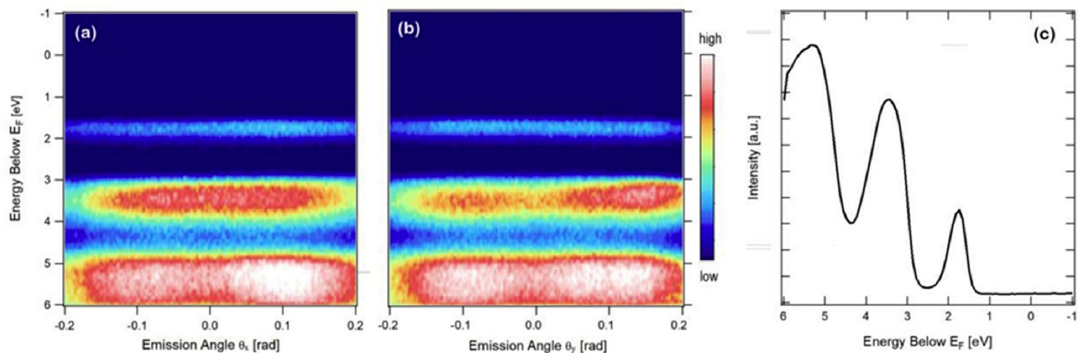
Figure 11. Angle-resolved perylene HOMO using the angle resolved time of flight (ARTOF) spectrometer as a function of photoelectron emission angle in ( a ) θ x and ( b ) θ y . In ( c ), spectra integrated in θ x and θ y from (a) and (b) show the HOMO. Measurements were performed with a photon energy of 60 eV and cw laser at 473 nm. From Ref. [90] with permission.